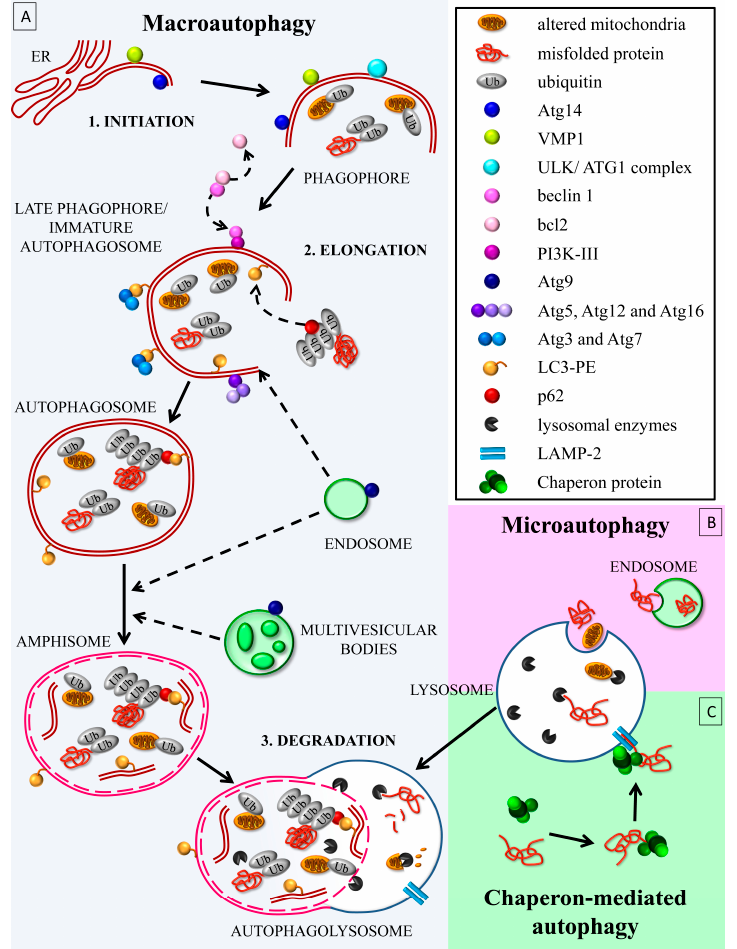
Figure 1. The autophagy (ATG) clearing pathway. ( A ) Macro-ATG follows the activation of the autophagy initiation complex, named the ATG1 or Unc-51 like autophagy activating kinase (ULK) (Unc-51 like autophagy activating kinase) complex. This leads to the phagophore, an incomplete double-membrane structure, which gems from the mitochondrial or endoplasmic reticulum carrying Atg14 and vacuolar membrane protein 1 (VMP1). The ULK/ATG1 complex phosphorylates Atg14, allowing the recruitment of beclin 1 from bcl2 on the phagophore membrane. Beclin 1 binds to phosphatidylinositol-3-kinase class III (PI3K-III)/VPS34, forming the active complex PI3K-III, which produces a focal increase of phosphatidylinositol-3-phosphate (PI3P). This leads to the followng: (i) the Atg9-mediated recruitment of endosomes and multivesicular bodies, and the (ii) induction of ubiquitin-like reactions. These consist of the formation of the Atg5/Atg12/Atg16 complex; or the assembly of the E1-like Atg7-mediated and the E2-like Atg3-mediated conjugation of LC3 to the phosphatidyletanolamine (PE), thus forming LC3-II (also called LC3 lipidation). Meanwhile, the late phagophore folds in order to enwrap the aged or damaged cell components, such as the ubiquitinated mitochondria and p62-bound poly-ubiquitinated proteins, which are sequestered within a mature autophagosome. The fusion between the autophagosome with the lysosome involves proteins belonging to the soluble N -ethylmaleimide sensitive factor attachment protein receptors (SNARE) complex. ( B ) Micro-ATG is traditionally described as a direct transport of several substrates into lysosomes for degradation; recently, it has been associated with the delivery of cargoes to late endosomes/multivesicular bodies. This latter process is dependent from ESCTR and Hsc70 proteins. ( C ) Chaperone-mediated ATG is a chaperone-mediated binding of specific substrates, which are delivered to the lysosomes through a lysosomal receptor, LAMP-2. Solid arrow: main step, Dotted arrow: molecule/vesicle